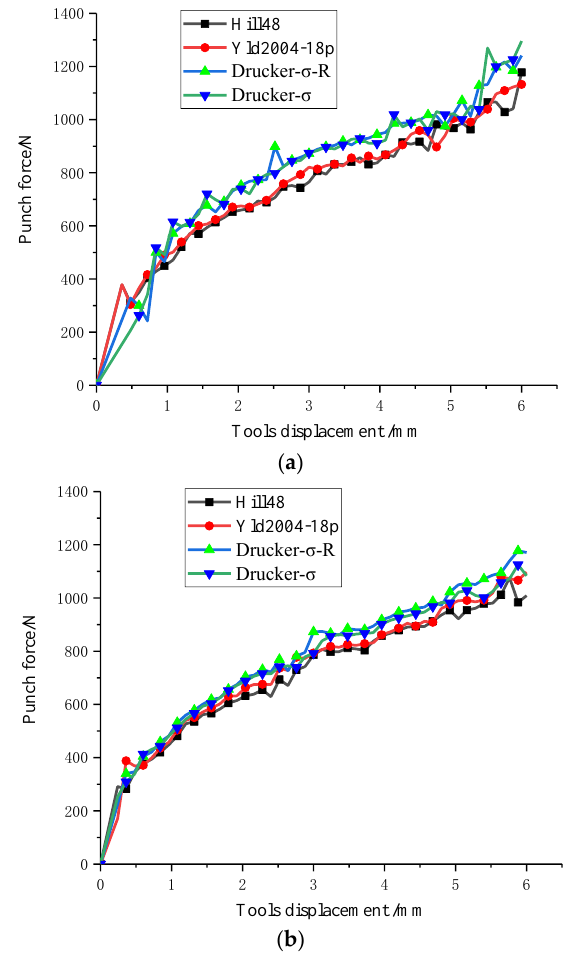
Figure 16. Predicted punch loading evolution for various yield criteria for Zirconium: ( a ) case through-thickness bending (TTB); ( b ) case in-plane bending (IPB).